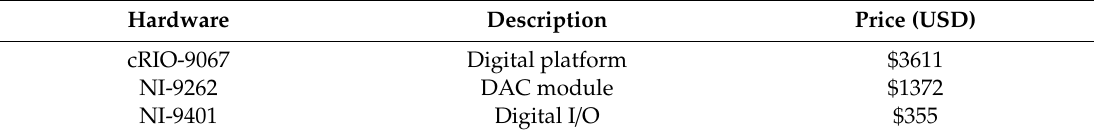
Table 8. HIL platform prices.